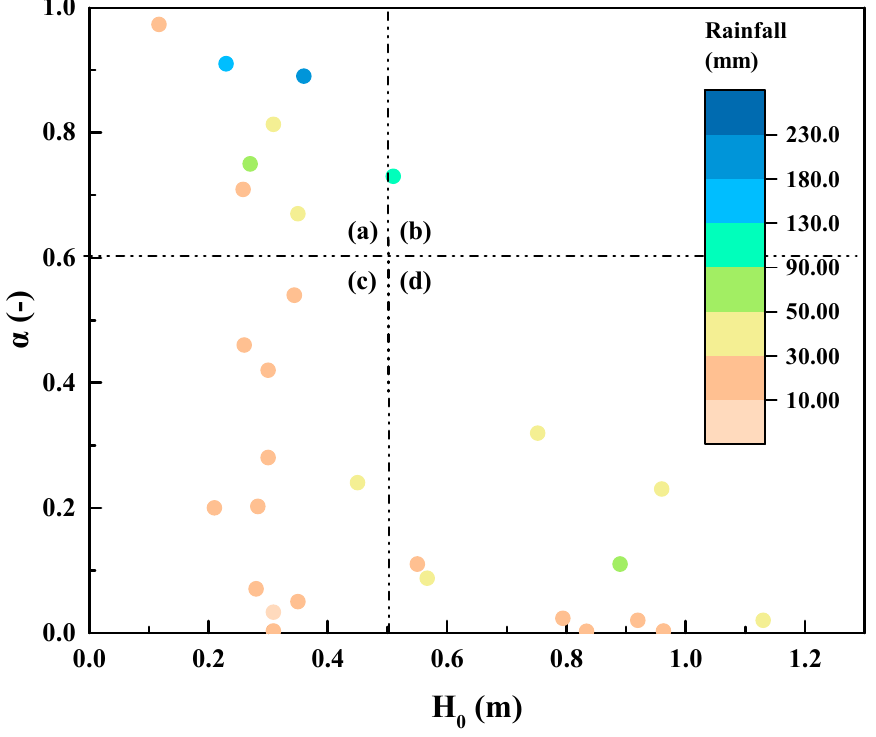
Figure 7. Runo ff coe ffi cient ( α ) versus the initial groundwater depth ( H 0 ) with di ff erent rainfall Figure 7. Runoff coefficient ( ɑ ) versus the initial groundwater depth ( H 0 ) with different rainfall depths.